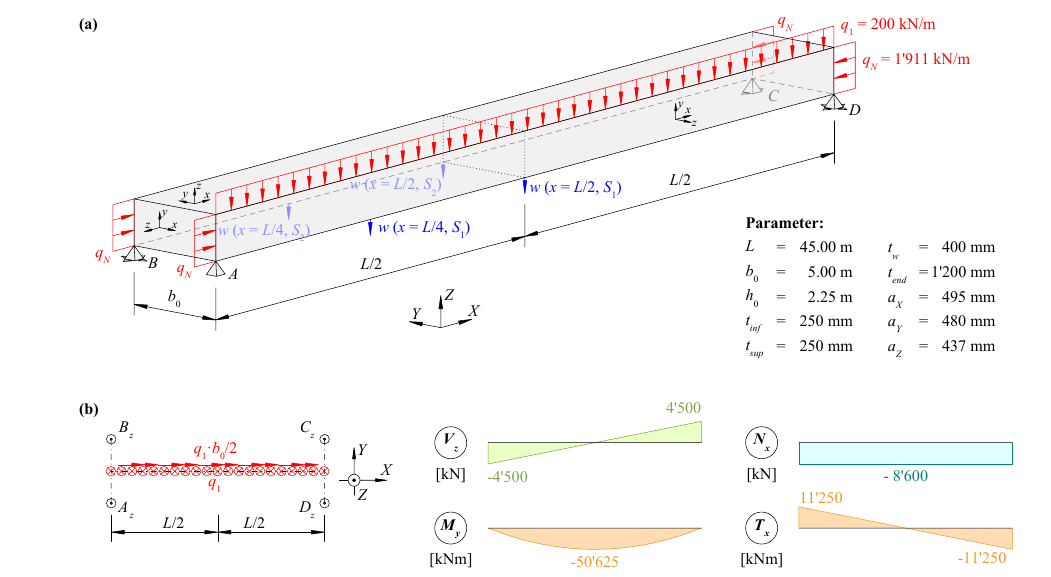
Figure 1. Dummy girder bridge used within ANSYS to generate the database.